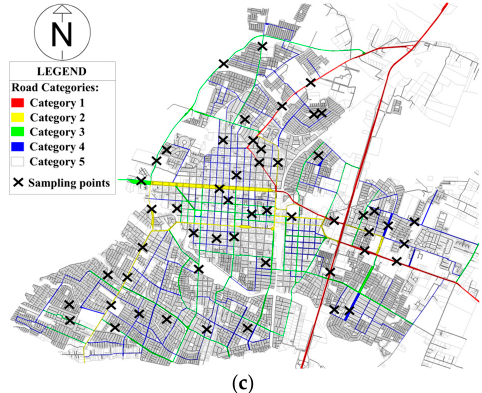
Figure 1. Sampling methods used in the city of Talca. ( a ) Sampling squares of grid method; ( b ) Ministry of Transport and Telecommunications (MTT) road types; ( c ) and categorisation method.